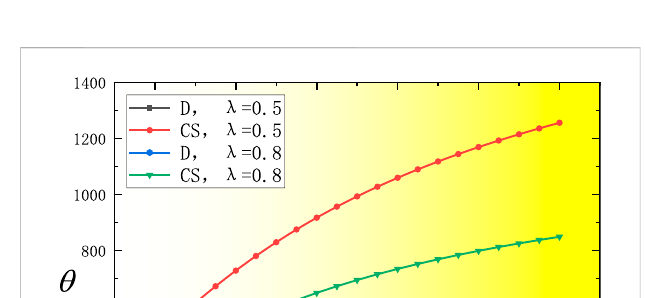
FIGURE 1 R impacts on wholesale prices.